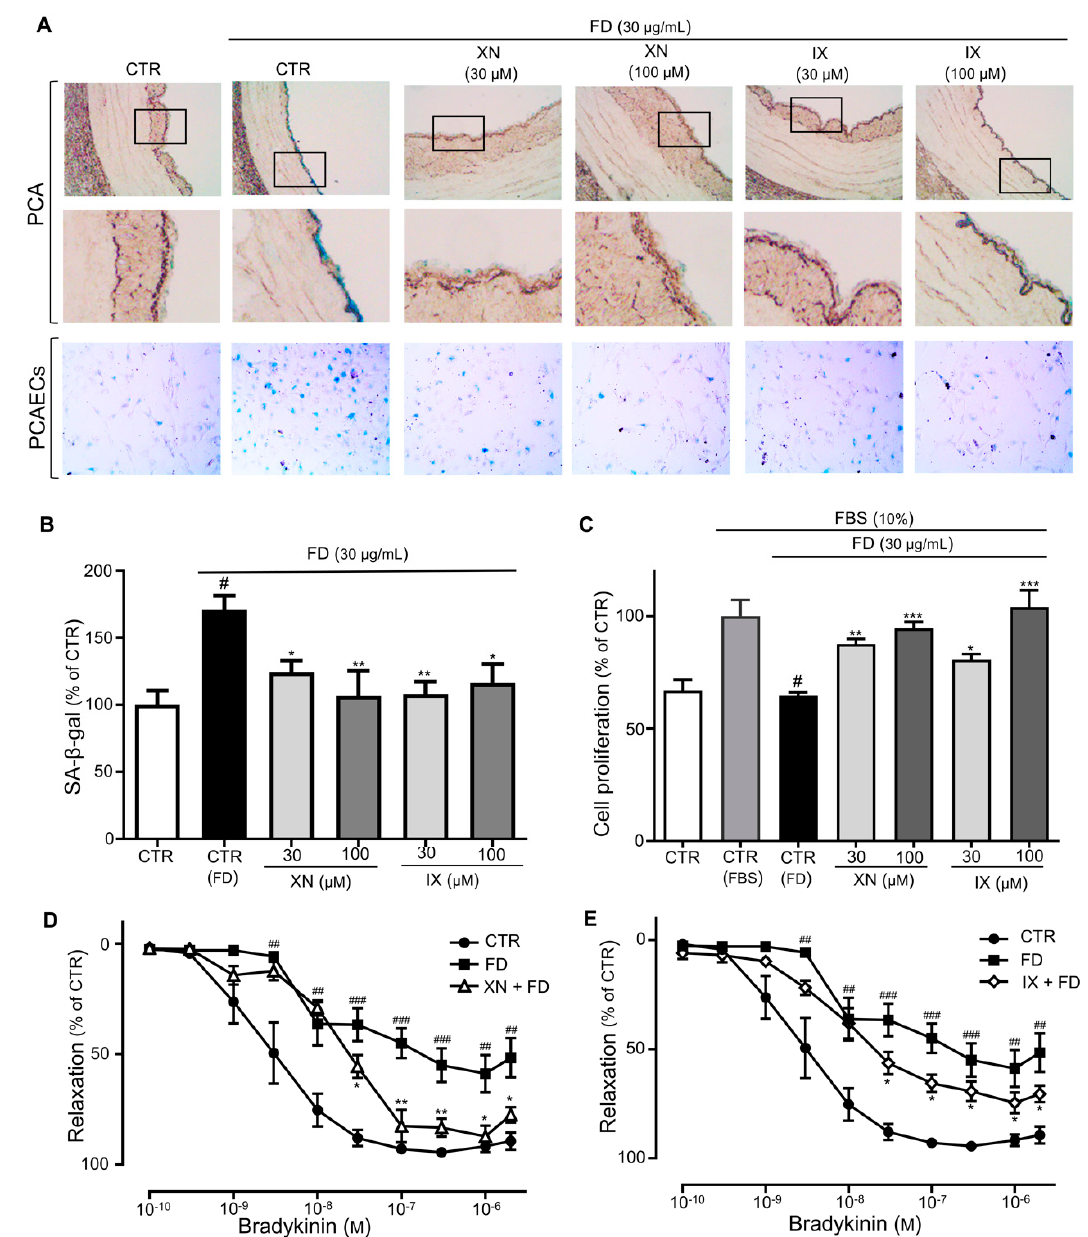
Figure 3. XN and IX prevent FD-induced premature senescence. ( A ) PCA rings and PCAECs were incubated in FD alone or FD in combination with XN or IX (30, 100 µ g / mL) before determination of SA- β -gal activity by X gal staining. Representative images of SA- β -gal-stained PCA rings and PCAECs. ( B) Cumulative data of SA- β -gal activity as a percentage of the control. Data are expressed as the mean ± SEM ( n = 6); # p < 0.05 vs. CTR; * p < 0.05, ** p < 0.01 vs. FD alone (CTR-FD). ( C ) Dose-dependent increases in cell proliferation after FD and XN / IX (10,30 µ M) treatment. Data are expressed as the mean ± SEM ( n = 6); # p < 0.05 vs. FBS alone (CTR-FBS); * p < 0.05, ** p < 0.01, *** p < 0.001 vs. FD alone (CTR-FD). ( D , E ) Concentration–relaxation curves of FD-exposed aortic rings treated with XN and IX (100 µ M) in response to bradykinin. Data are expressed as the mean ± SEM ( n = 7–10); ## p < 0.01, ### p < 0.001 vs. CTR; * p < 0.05, ** p < 0.01 vs. FD alone (CTR-FD).